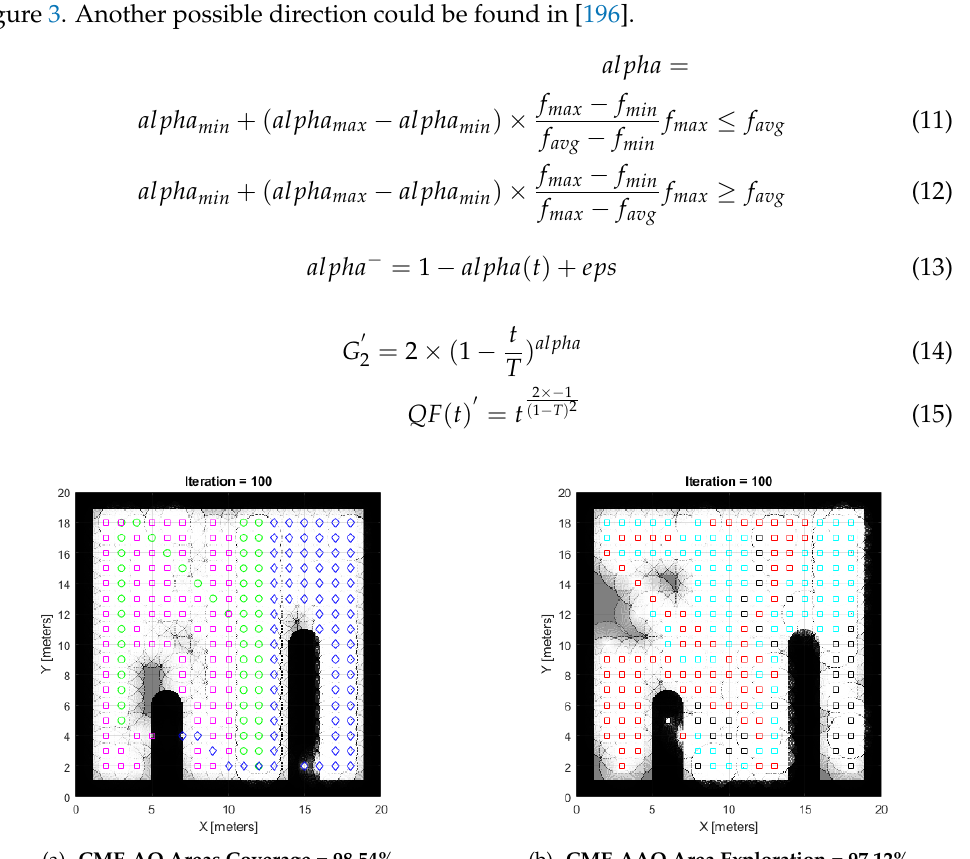
Figure 3. The simulation of CME-AO and CME-AAO exploration